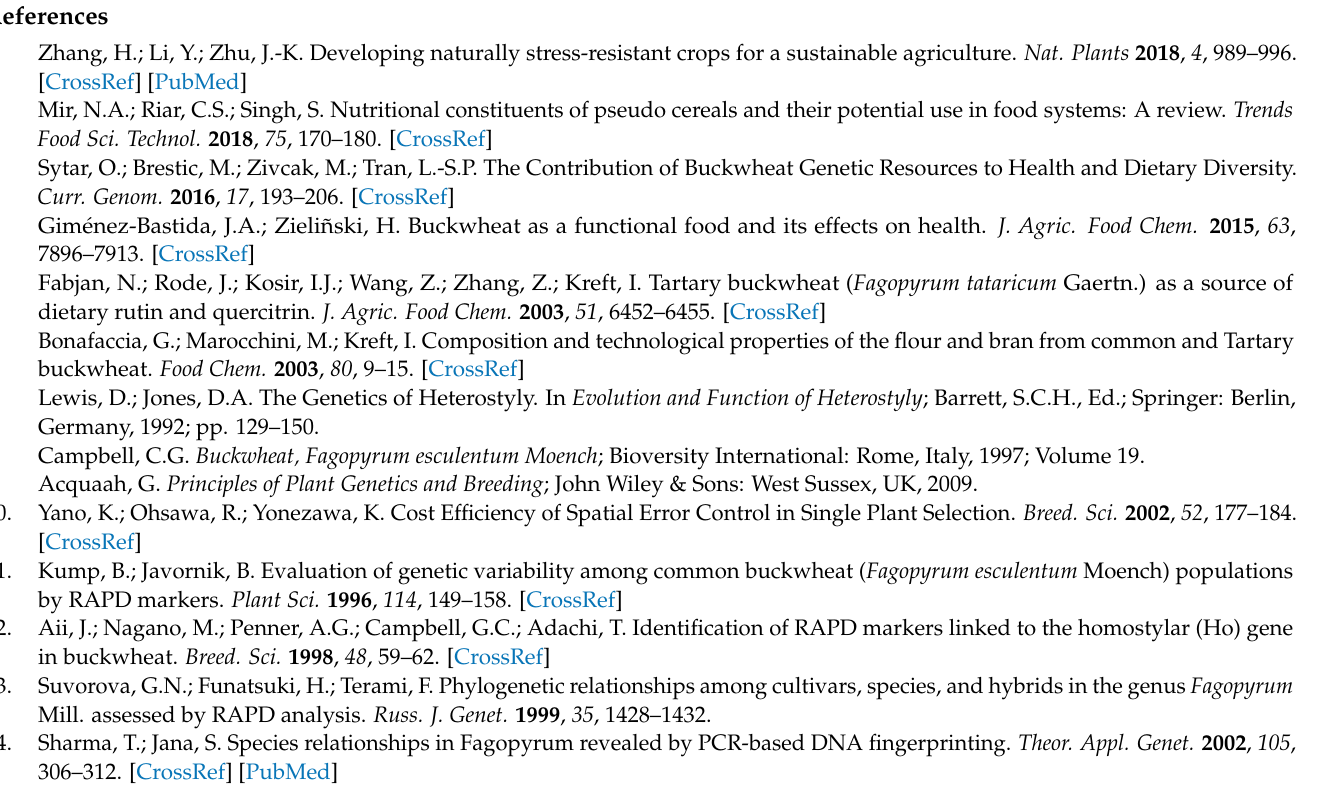
Table S4: Details of InDel identified in the F. esculentum transcriptome. Table S5: Expression and functional annotation of unigenes corresponding to markers located in the QTL region. Table S6: The physical positions of markers located on genetic maps on the genomes of Common buckwheat and Tartary